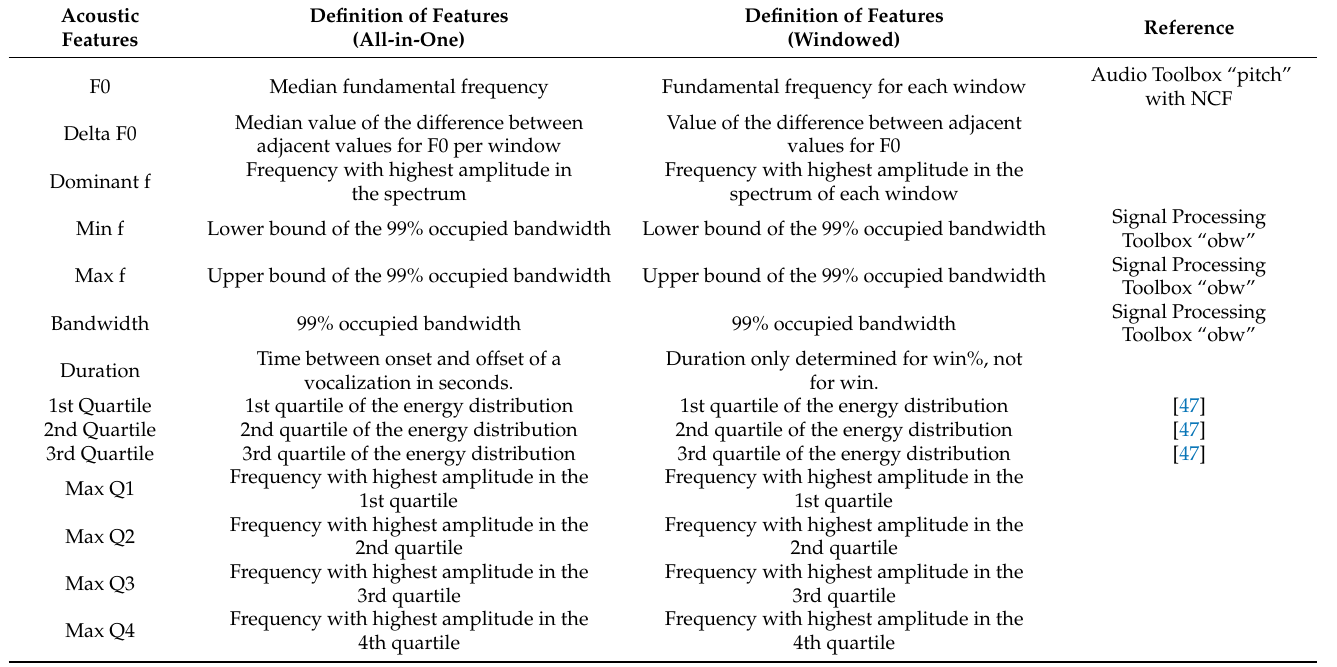
Table 1. List of acoustic features extracted for one vocalization (All-in-one) or for each time window of one vocalization (windowed). The commands (in quotes) and toolboxes mentioned in the reference column all refer to